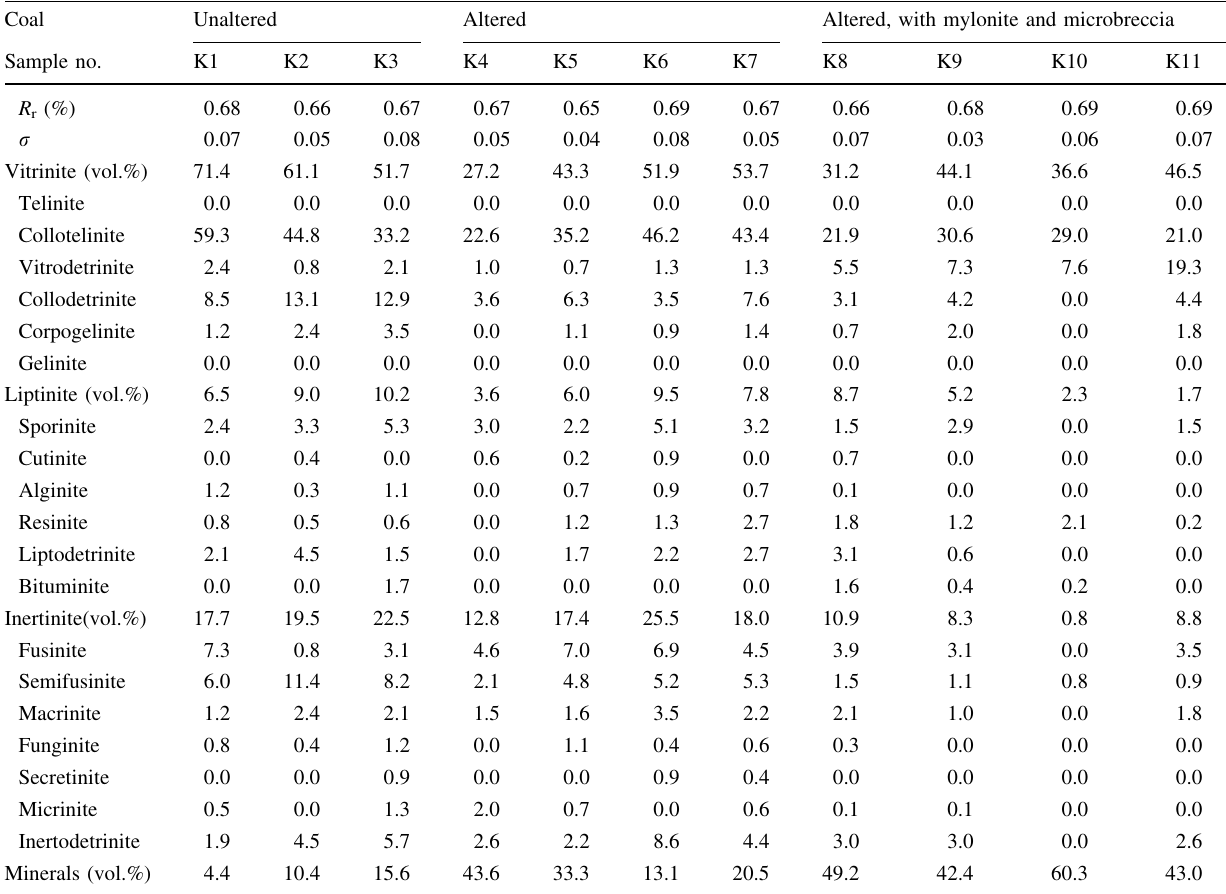
Table 3 Rank and maceral composition of the Kladno coal samples K1–K11